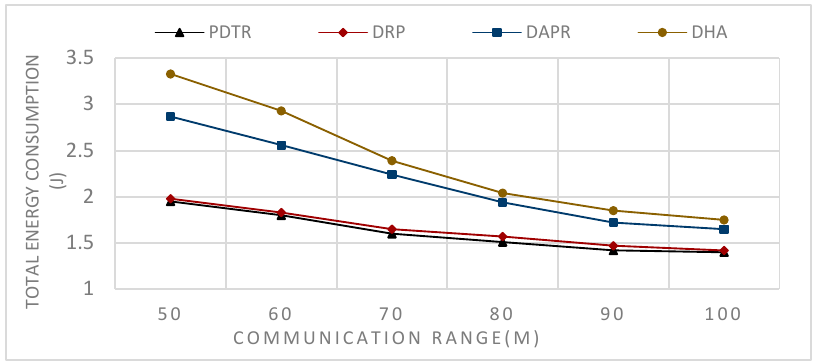
Figure 8. Impact of varying communication range on total energy consumption.